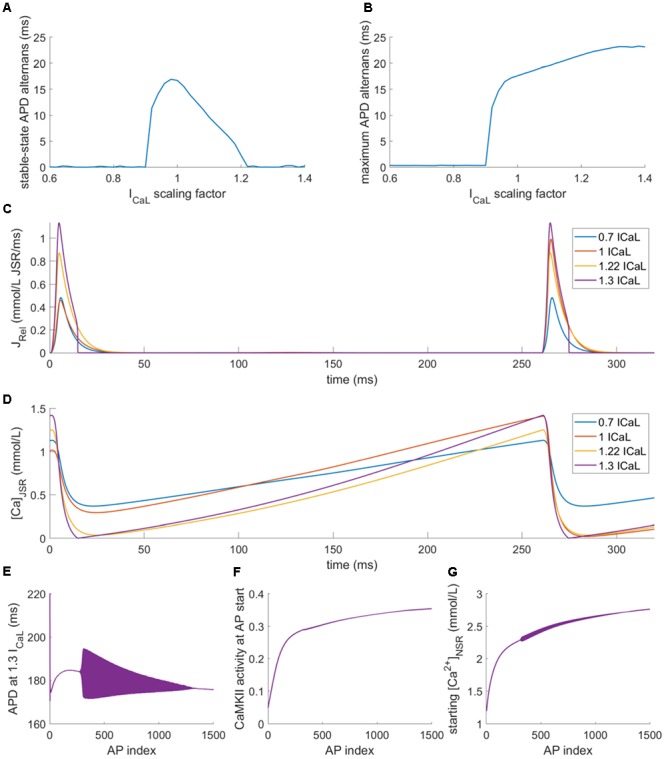
Alternans at 260 ms bcl with varied ICaL conductance in the HeRd model. (A) APD alternans amplitude (difference in APD between last two APs) at the end of stable-state pre-pacing. (B) Maximum APD alternans (difference in two consecutive APs) at any stage between pre-pacing APs 30–2500 (first 30 APs were omitted as the model may manifest large APD changes at the start of the simulations, which are not due to alternans). (C) Examples of Jrel for four ICaL scaling factors after stable-state pre-pacing, showing alternans for ICaL scaling factor of 0.7 and 1 but not for 1.22 or 1.3; (D) JSR calcium levels aligned with the plot (C), showing full depletion in both beats at calcium scaling factors of 1.22 and 1.3. (E) Development of APD during pre-pacing for ICaL scaling factor of 1.3, the filled area represents alternans of APD; first 1500 beats of pre-pacing shown. (F) Increasing CaMKII activity during pre-pacing for ICaL scaling factor of 1.3. (G) Increasing NSR loading during pre-pacing of the model with ICaL scaling factor of 1.3, measured as NSR calcium at the start of an action potential.